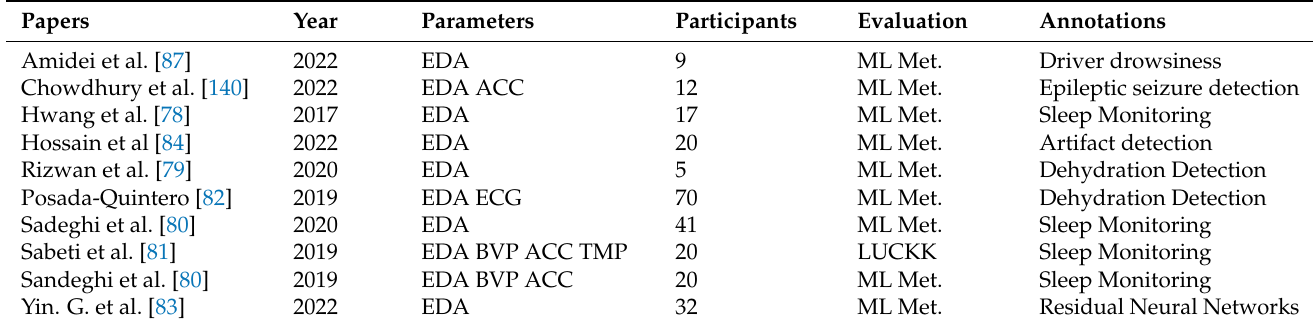
Table 10. Physiological signals used for other physical states